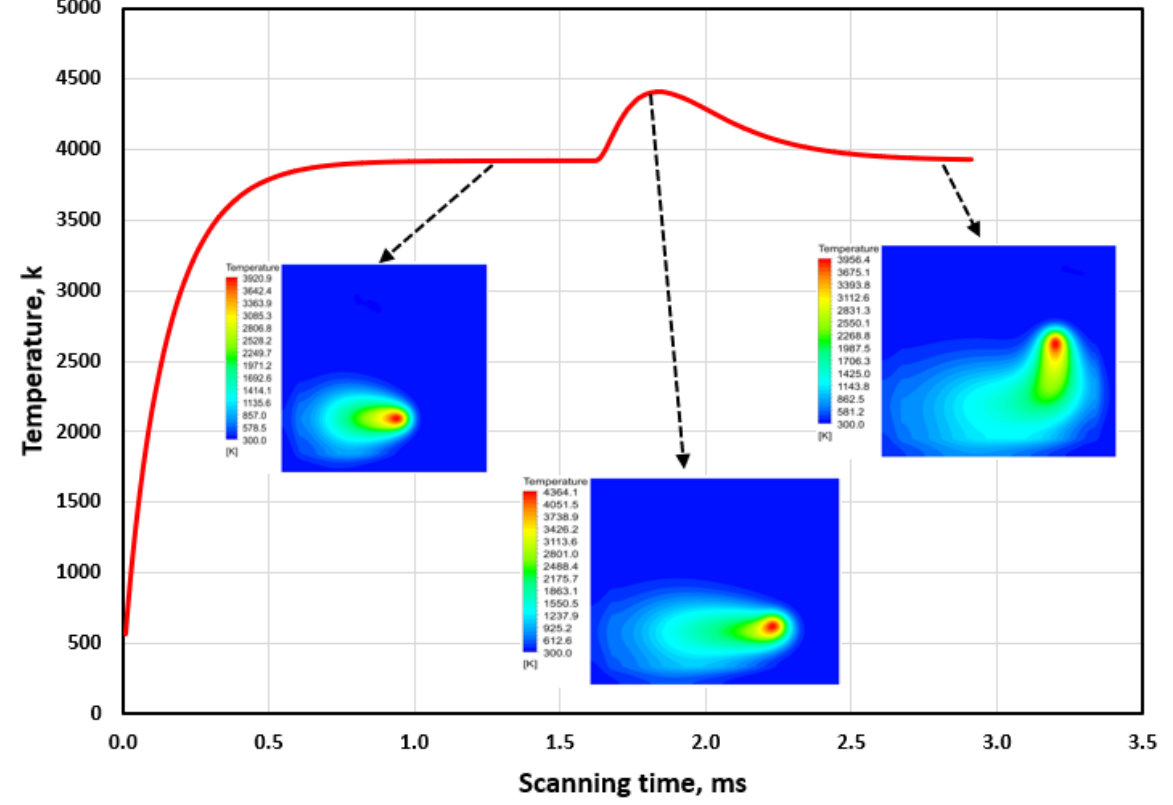
Figure 15 . The sharp increase in temperature due to the change in the laser direction. Figure 15. The sharp increase in temperature due to the change in the laser direction.